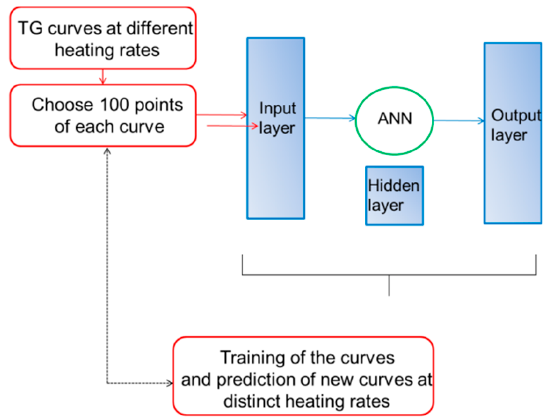
Figure 1. Flowchart of the calculation process.